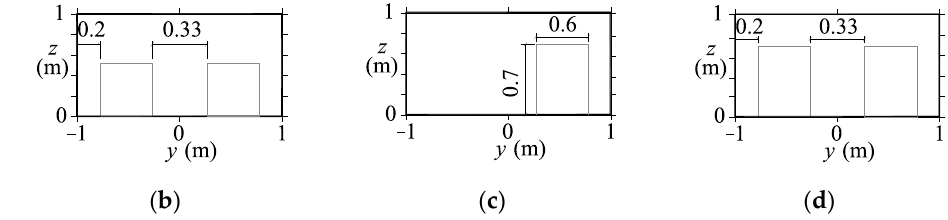
Figure 4. Schematic of vehicular configurations and heights in the model: ( a ) Low obstacles in M1 ; ( b ) Low obstacles in M2 ; ( c ) High obstacles in M1 ; ( d ) High obstacles in M2 .